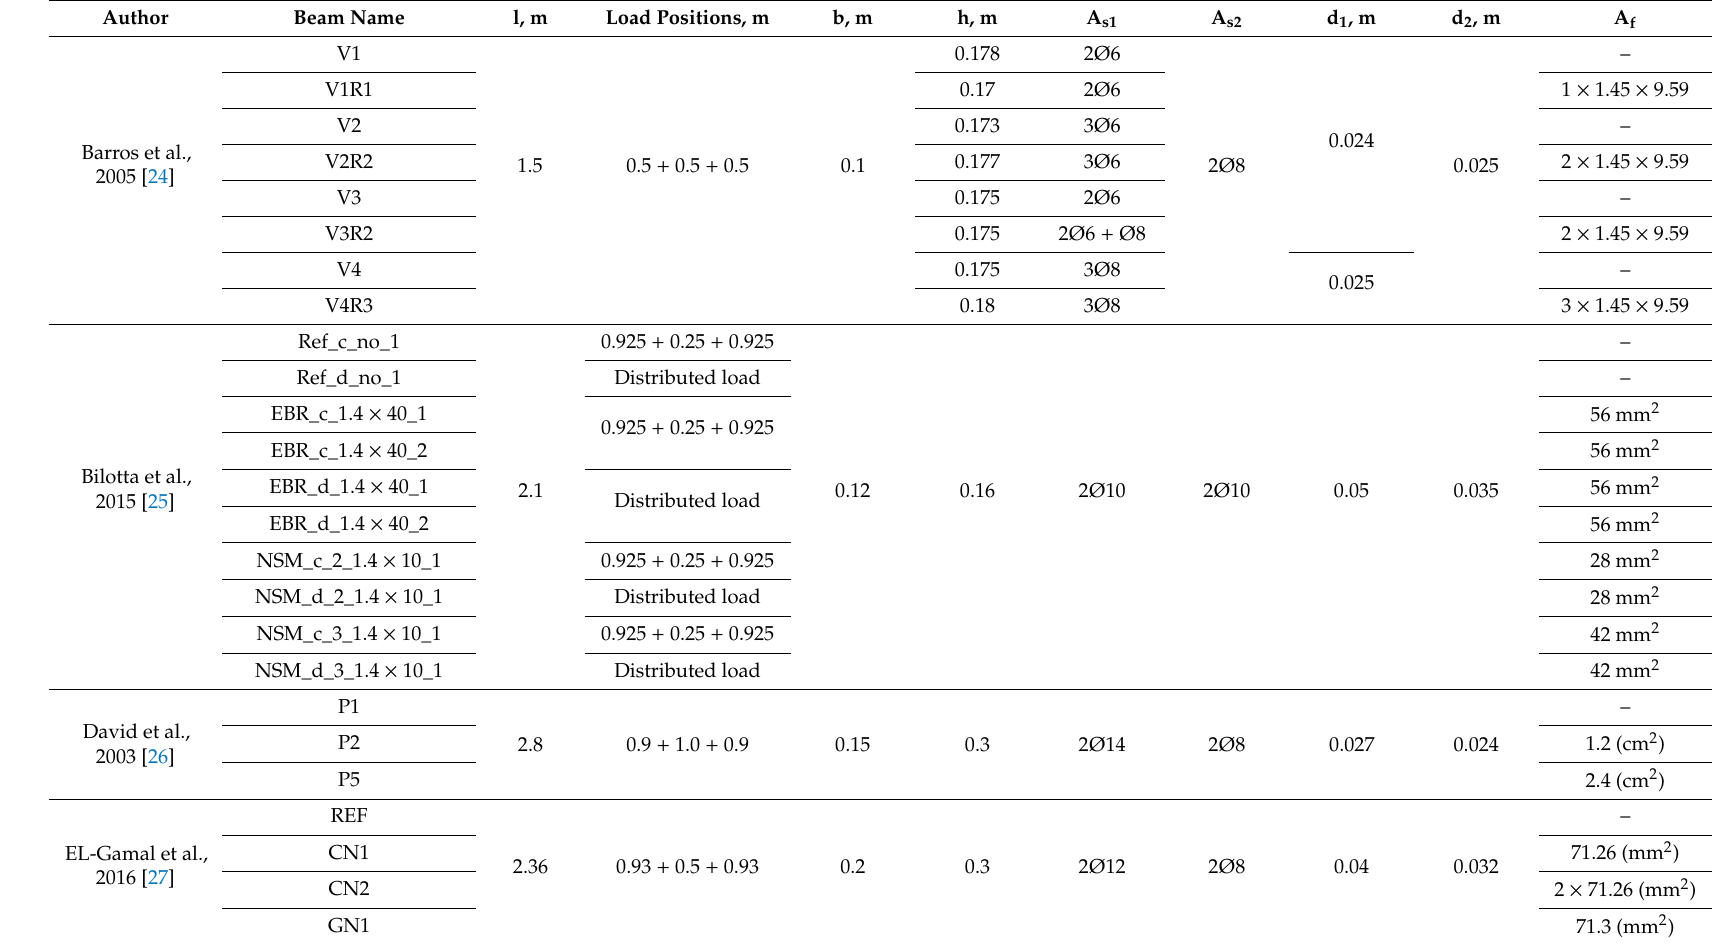
Table 1. Characteristics of investigated experimental